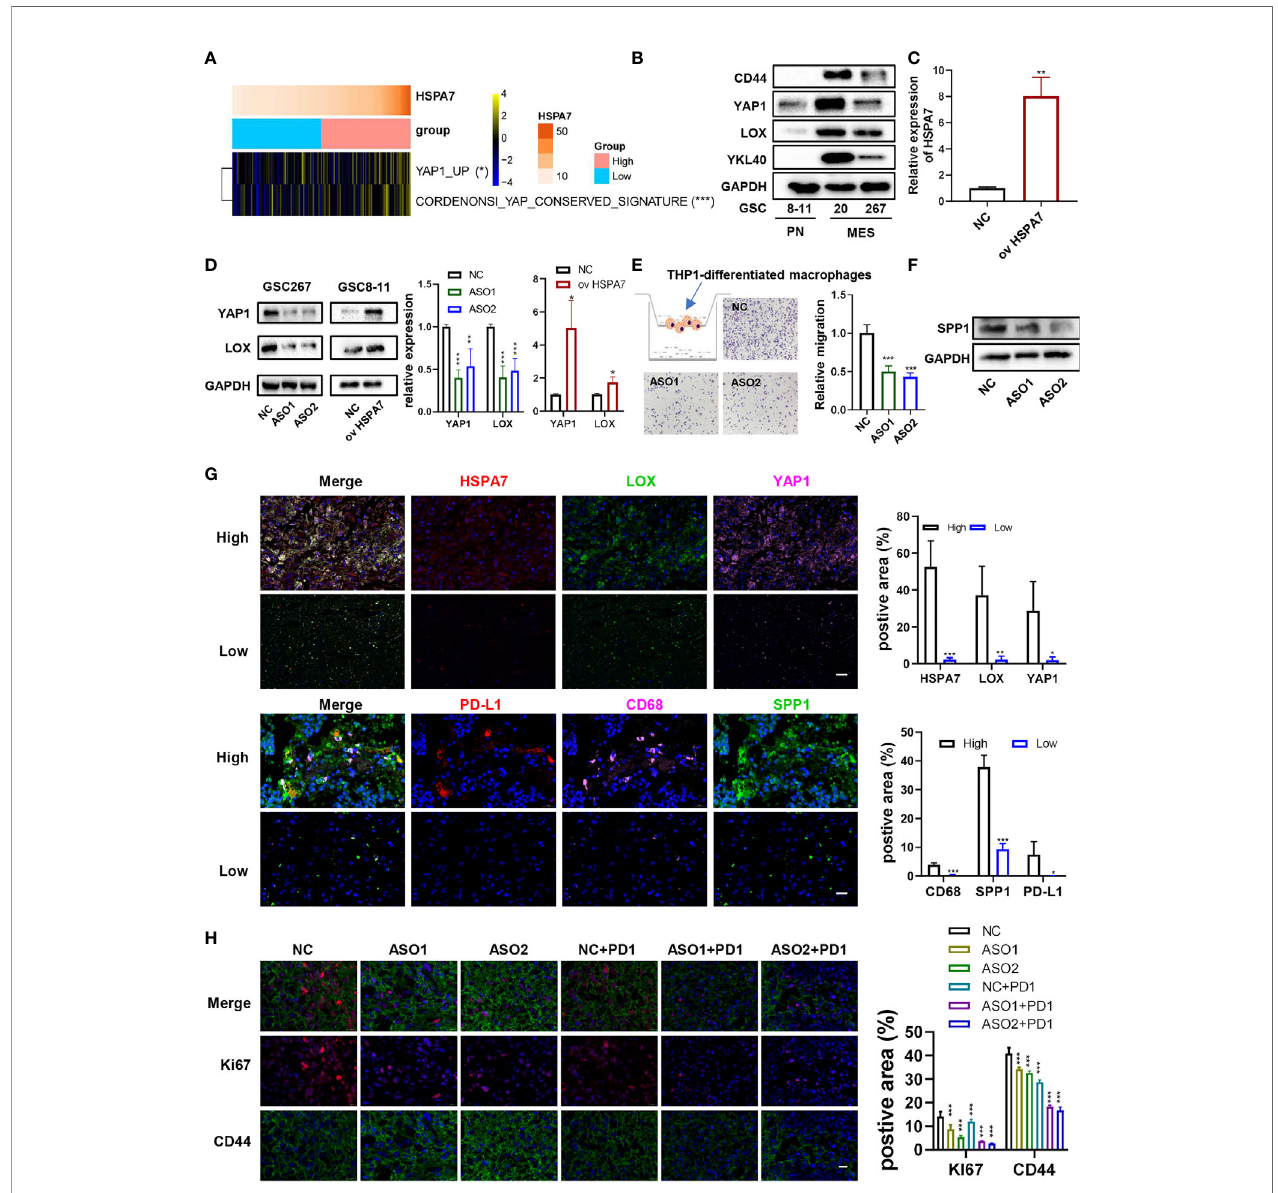
FIGURE 7 | HSPA7 facilitated macrophage in fi ltration and might be a novel immunotherapy target for GBM patients. (A) The heatmap shows that HSPA7 activated YAP1 signaling. The asterisks indicate a signi fi cant statistical p-value calculated using the non-parametric Wilcoxon test (*P < 0.05; **P < 0.01; ***P < 0.001). (B) The protein expression of CD44, YAP1, LOX, and YKL40 in PN subtype GSCs (GSCs 8 – 11) and MES subtype GSCs (GSCs 20 and 267). (C) qPCR assays veri fi ed the overexpression ef fi ciency of HSPA7. (D) Representative Western blot assays showed that HSPA7 promoted the expression of YAP1 and LOX, a macrophage chemoattractant (left), and quanti fi cation histogram represented the relative protein expression of LOX and YAP1 (right); data are presented as the mean ± SD, n = 3. *p < 0.05, **p < 0.01, ***p < 0.001. Means were compared with Student ’ s t -test for two groups and one-way ANOVA for three groups, and the NC group is indicated as the control. (E) Representative transwell migration assays showed that HSPA7 inhibited human THP1-differentiated macrophage migration by exposing them to conditioned medium from GSC 267 cells transfected with NC, HSPA7 ASO1, or ASO2 for 24 h. Original magni fi cation, ×100 (left), and quanti fi cation histogram represented relative migration of THP-1 macrophages (right); data are presented as the mean ± SD, n = 3. *p < 0.05, **p < 0.01, ***p < 0.001. Means were compared with one-way ANOVA, and the NC group is indicated as the control. (F) Western blot assays showed that HSPA7 inhibited the expression of SPP1 in THP1-differentiated macrophages by exposing them to conditioned medium from GSC 267 cells transfected with NC, HSPA7 ASO1, or ASO2 for 48 h. (G) IF staining in a human GBM tissue microarray showed that the expression of LOX, YAP1, PD-L1, CD68, and SPP1 was higher in the HSPA7 high group than in the low group. Histogram representing statistical proportion data of positive area; data are presented as the mean ± SD, n = 3. *p < 0.05, **p < 0.01, ***p < 0.001, means were compared with Student ’ s t -test. (H) GBOs at 2 weeks were cocultured with conditioned medium from GSC 267 cells, transfected with NC, HSPA7 ASO1, or ASO2 at 48 h, and PD1 antibody (5 m M) for 5 days as indicated. IF staining for Ki67 and CD44 in GBO sections showed that knockdown of HSPA7 enhanced the effect of anti-PD1 therapy, original magni fi cation, ×630 (scale bars: 20 m m). Histogram representing statistical proportion data of positive area; data are presented as the mean ± SD, n = 3. *p < 0.05, **p < 0.01, ***p < 0.001. Means were compared with one-way ANOVA, and the NC group is indicated as the